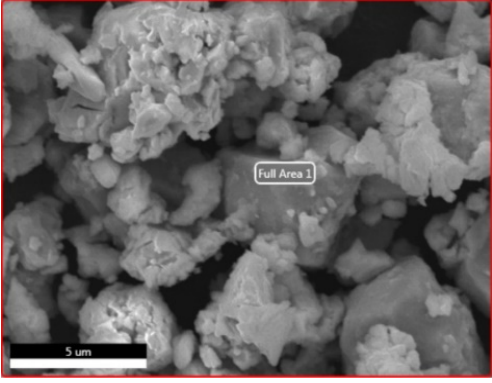
Figure 3. XRD pattern of NdFeB magnet powders.